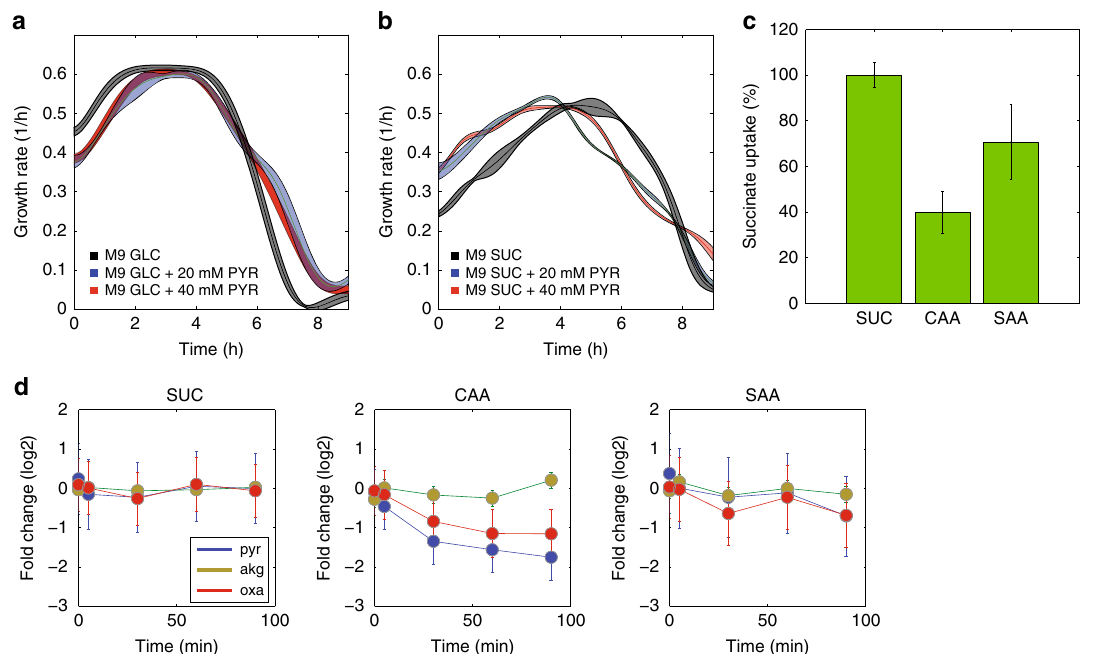
Fig. 6 Coordination of succinate and amino acid catabolism. a Changes in the instantaneous growth rate of E. coli in glucose M9 (black), with 20 (blue), or 40 (red) mM of pyruvate. b Changes in the instantaneous growth rate of E. coli in succinate M9 (black), with 20 (blue) or 40 (red) mM of pyruvate. c Relative succinate uptake rates of E. coli in succinate M9, supplemented with 2 g/L CAA or a synthetic mix of amino acids (SAA) consisting of the same amino acids and concentrations measured in 2 g/L CAA. Error bars represent the 95% con fi dence interval from fi tting analysis of three biological replicates (see Supplementary Fig. 21). d Dynamic relative changes in the abundance of pyruvate (blue), oxaloacetate (red) and α -ketoglutarate (brown) upon supplementation with the amino acid mixtures and succinate as the main carbon